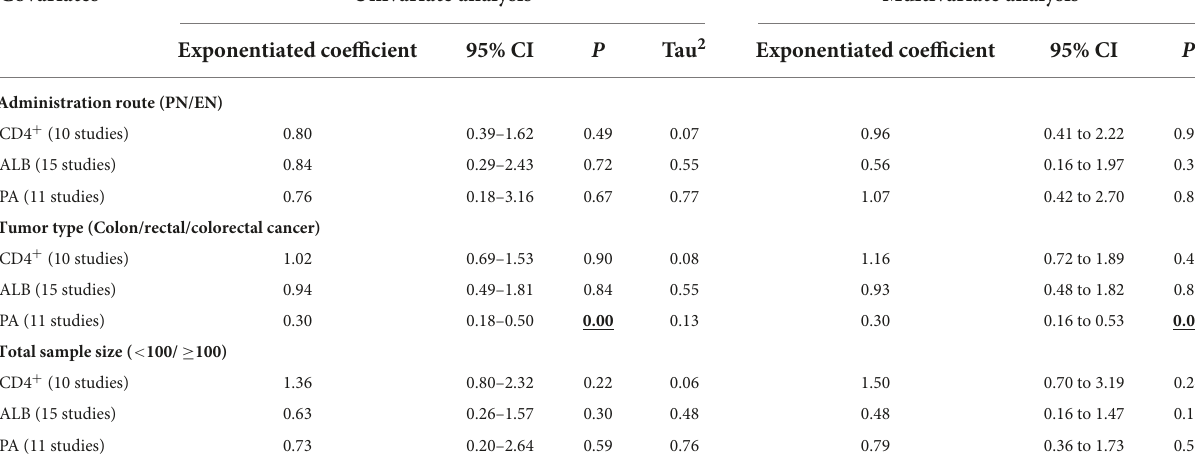
TABLE 2 Results of meta-regression analysis.